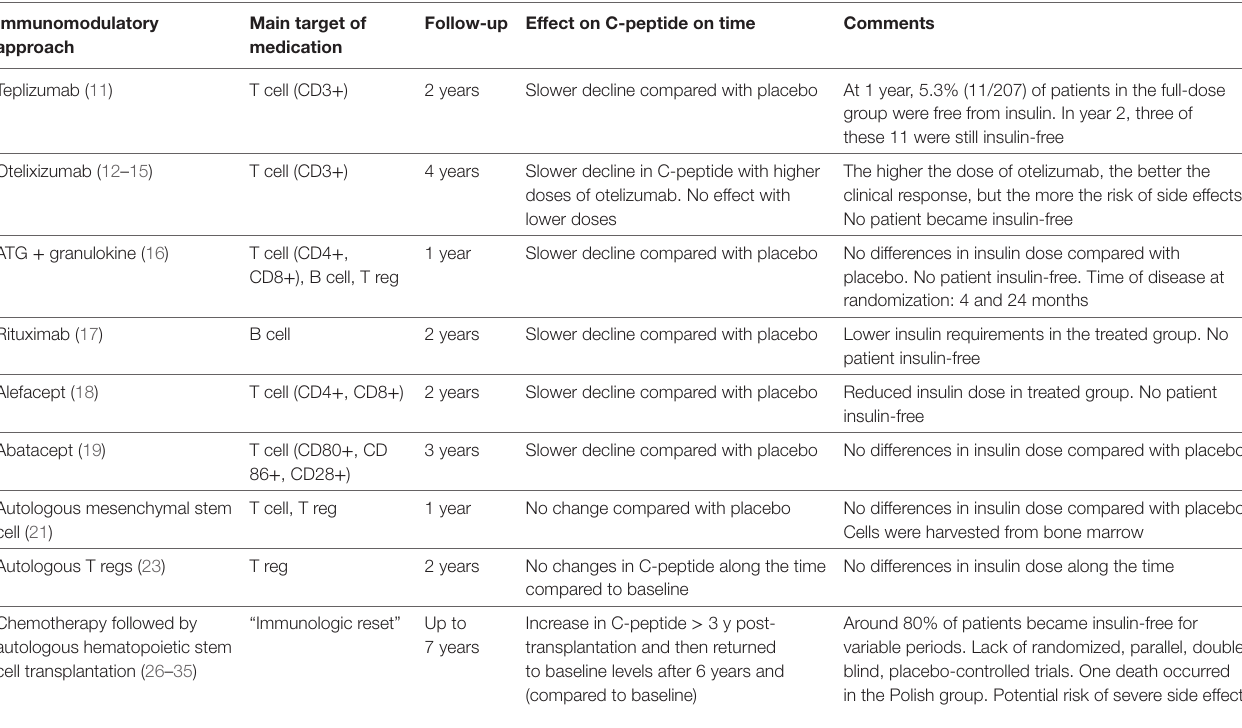
tABLe 1 | Recent secondary prevention trials in individuals with type 1 diabetes and their effect on beta cell